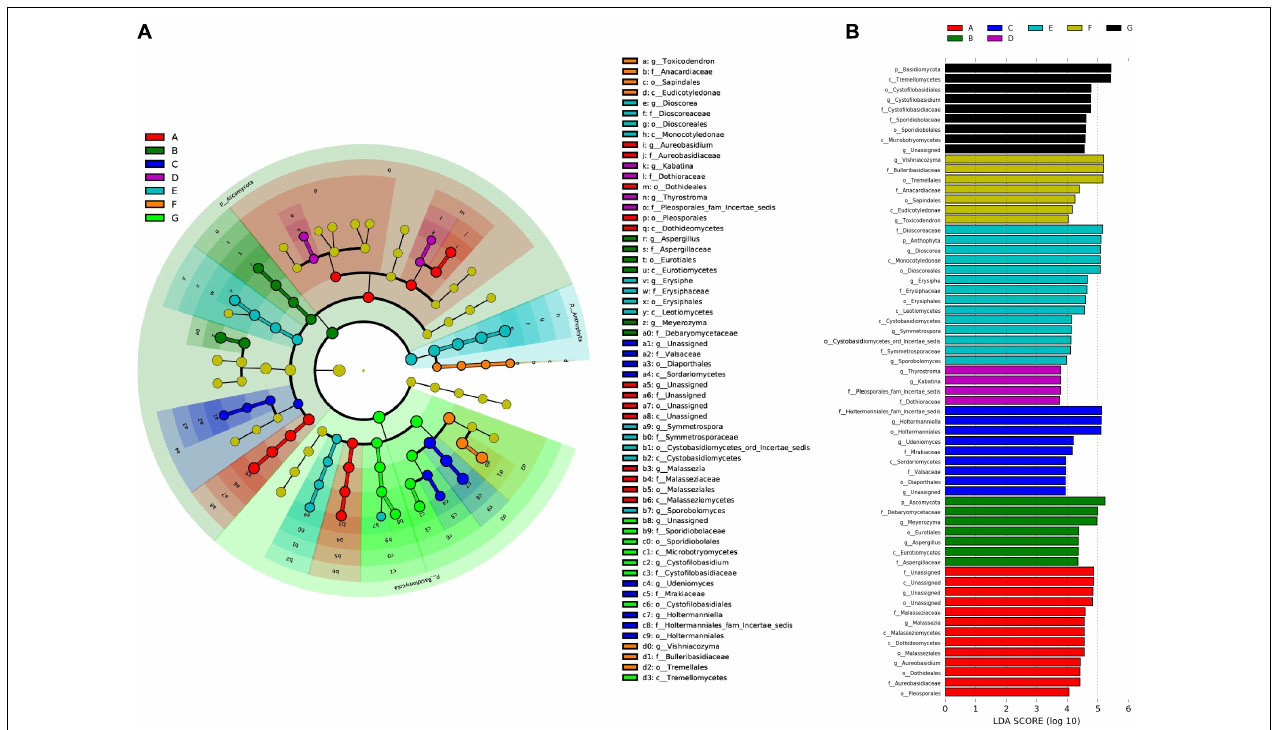
FIGURE 8 | Linear discriminant analysis (LDA) and effect size (LEfSe). (A) The bar charts report the taxonomic representation statistically and biologically as determined by LEfSe analysis; (B) the linear discriminant analysis (LDA) value distribution histogram.